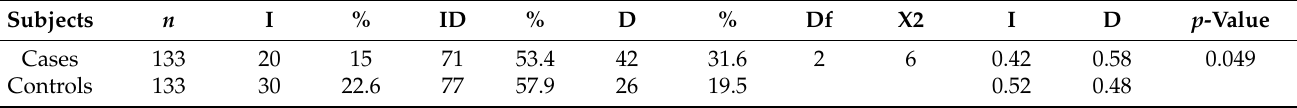
Table 3. The distribution of VEGF -2549 I/D polymorphism genotypes in T2D cases and